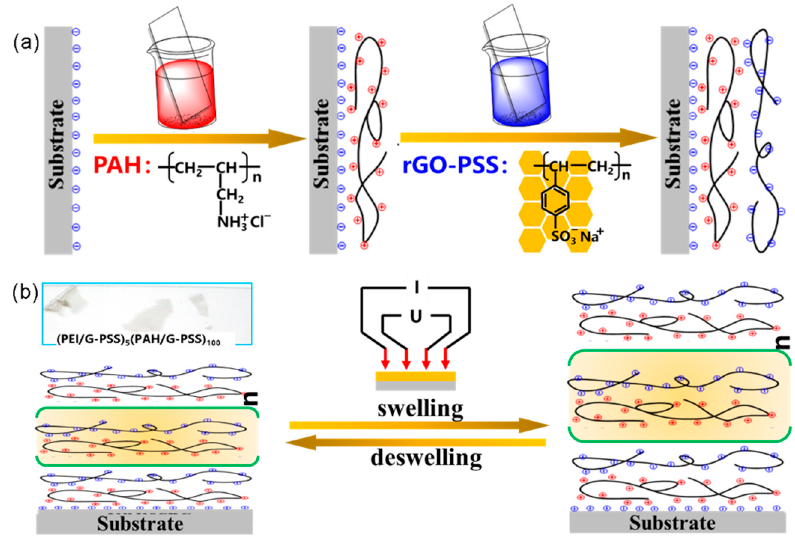
Figure 1. ( a ) Schematic diagram of one layer-by-layer assembly cycle. The black solid line represents the changed and reduced graphene oxide. The symbols “ ⊖ ” and “ ⊕ ” represent the negative and positive charges, respectively. The red-colored solution is PAH and the blue-colored solution is rGO-PSS. ( b ) The sheet resistance affected by H 2 O concentrations was tested with a four-probe method.